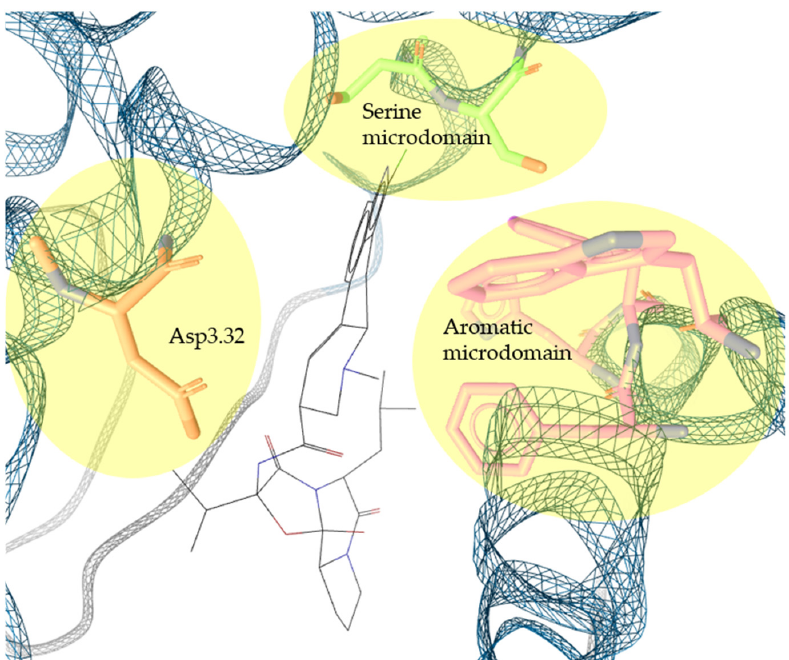
Figure 1. Overview of the highly conserved D 2 R orthosteric binding pocket. Asp3.32, the serine microdomain, and the aromatic microdomain responsible for ligand binding, orientation, and receptor activation are highlighted. Picture generated in LigandScout (based on cryo-EM structure 7jvr [23]) showing bromocriptine in the orthosteric binding pocket.